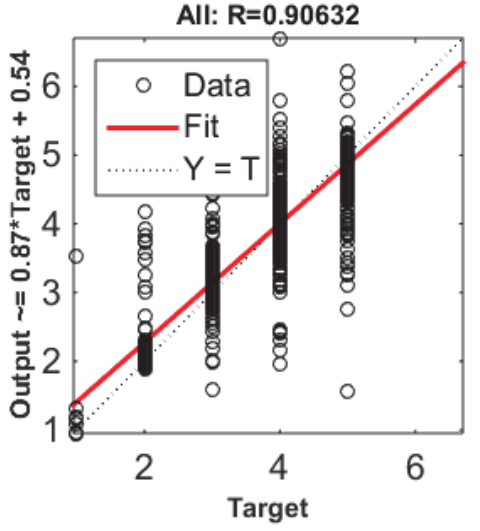
Fig. 6. network’s regression diagram